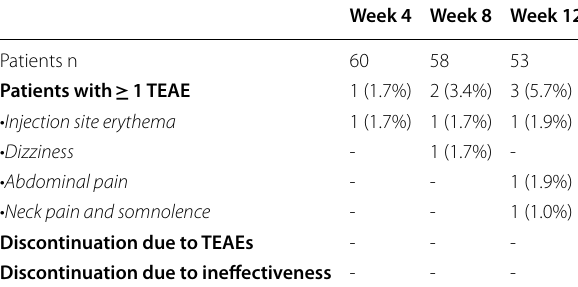
Table 3 Treatment-emergent adverse event (TEAEs) occurring at weeks 4, 8 and